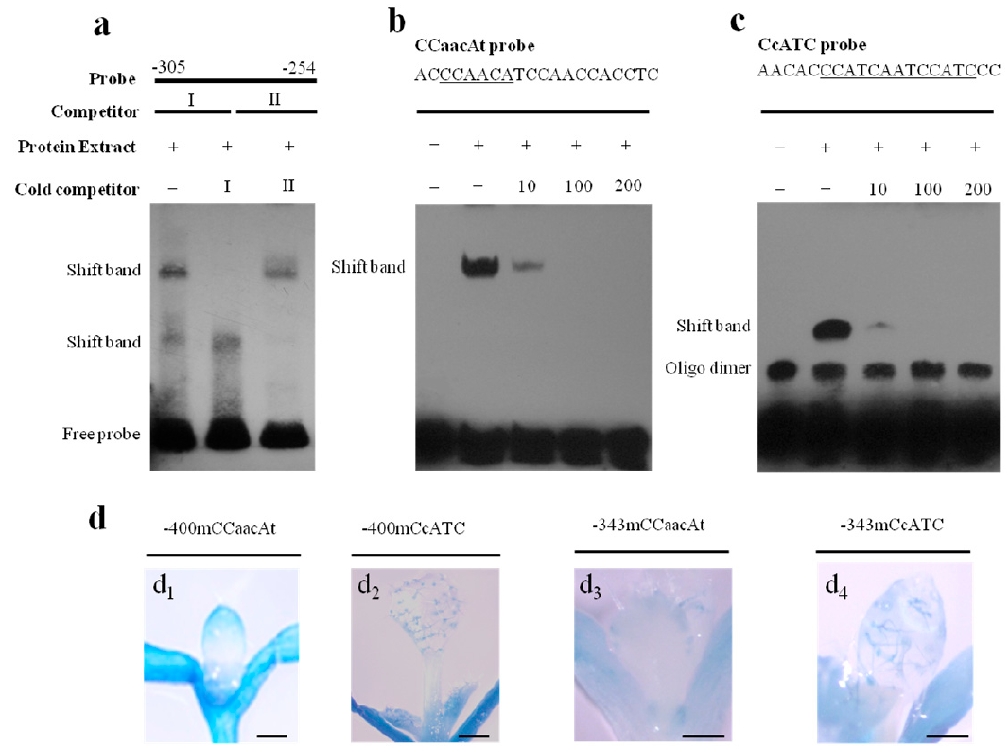
Figure 4. Epidermis-specific expression regulated by CCaacAt and CcATC motifs. ( a ) EMSA using upstream sequence from − 305 to − 254 bp as probe and non-labeled promoter fragments ( − 305 to − 280 bp, − 279 to − 254 bp) as competitors. Whole cell proteins were extracted from two-week-old wheat seedlings; ( b , c ) EMSA using short probes containing the CCaacAt motif and CcATC motif ( − 305 to − 285 bp, − 274 to − 254 bp). Unlabeled fragments with the same sequence as probe were used as competitors. A plus sign ( + ) represents the sample was added and a minus sign ( − ) represents not; ( d ) GUS activity of A. thaliana transformed with − 400 TaLTP1 :: uidA harboring mutated CCaacAt motif